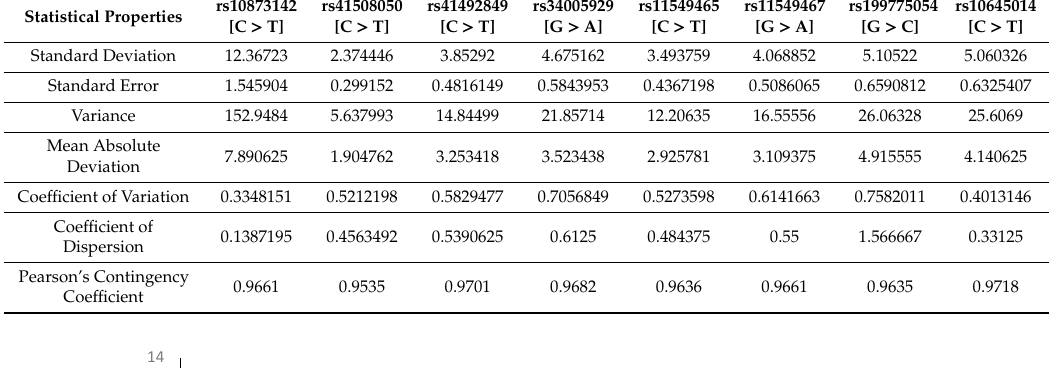
Table 5. Statistical properties of graphs Γ ( ϕ i , j ) of sequence ( ϕ i , j ) from cancer DNA sequences.